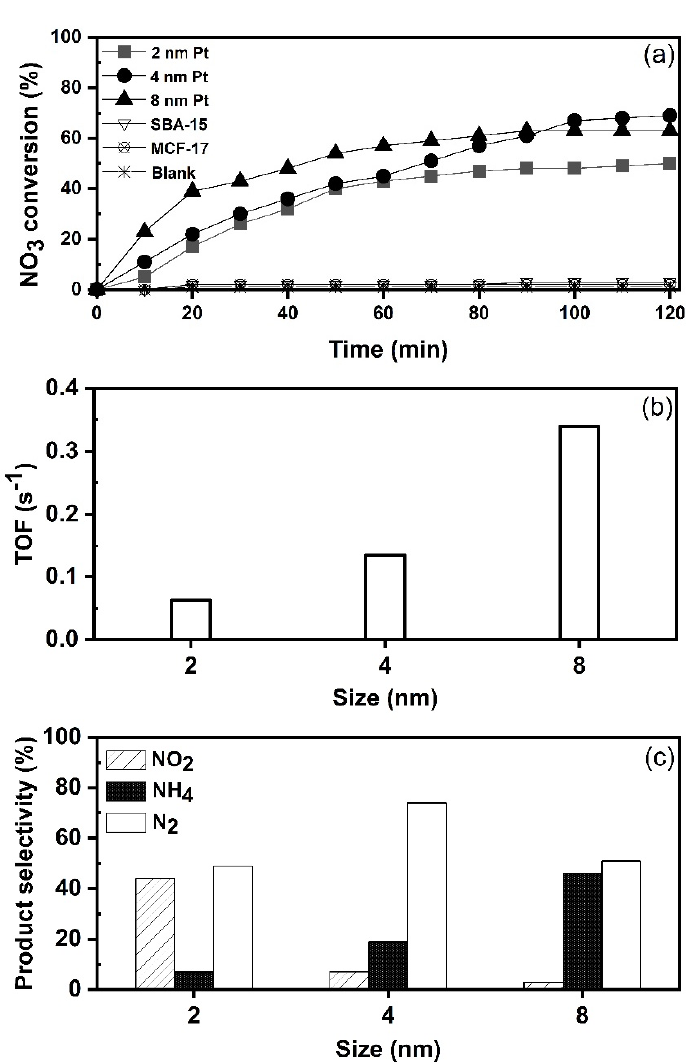
Figure 4. Effect of Pt nanoparticle size on nitrate reduction (catalyst 1 g L − 1 , NO (cid:2871)(cid:2879) 100 mg L − 1 , H (cid:2870) 100 mL min − 1 at 25 °C): ( a ) nitrate conversion with time; ( b ) TOF values calculated at first 20 min reaction time (mM of NO (cid:2871)(cid:2879) molecules converted per active site per s); and ( c ) product selectivity at 120 min of reaction time.